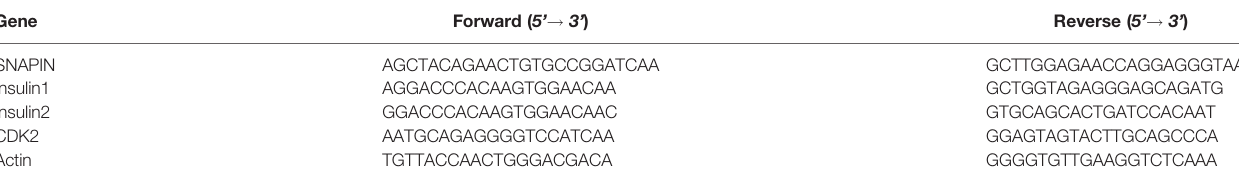
TABLE 2 | Real-time PCR primer